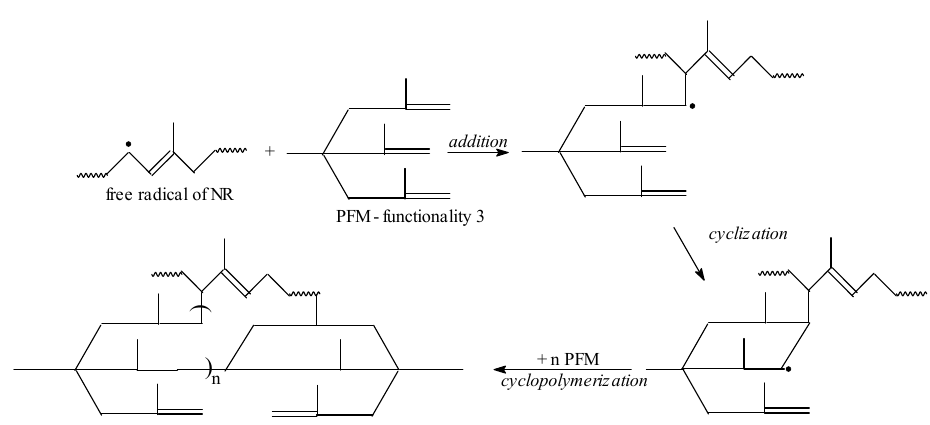
Figure 5. Possible mechanism of TMPT cyclopolymerization on NR.